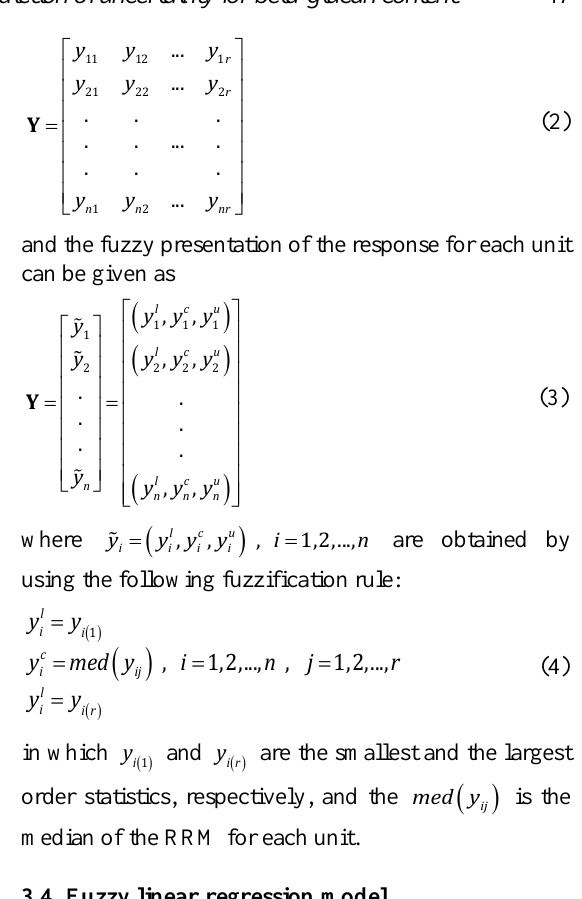
Figure 1. A presentation of